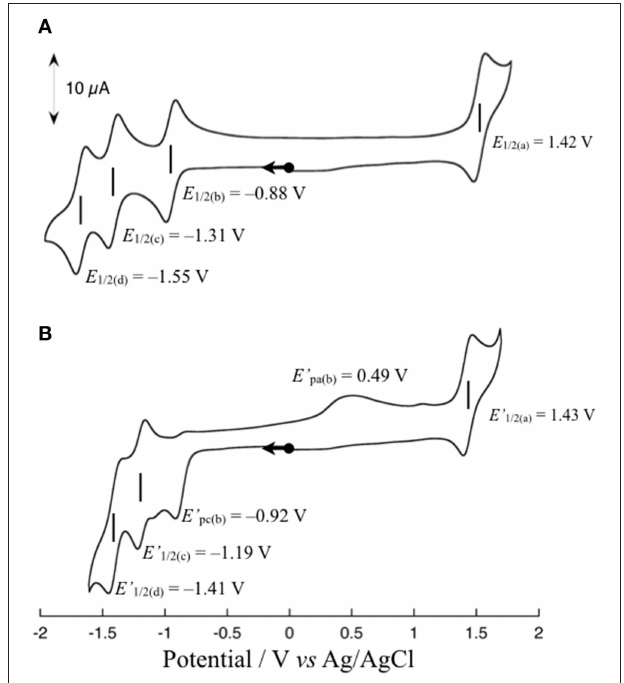
FIGURE 3 | Cyclic voltammograms of 1 in the absence (A) and presence (B) of 10 equivalents of AcOH in DMF containing 0.1M TBAPF 6 at a scan rate 50mV s − 1 . All scans are started from the rest